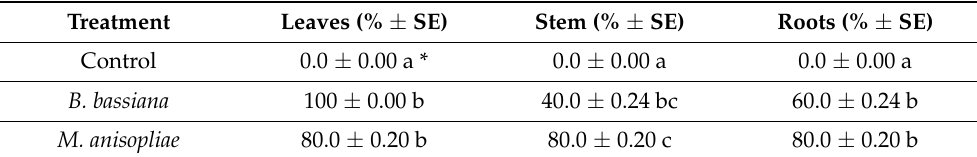
Table 1. Effect of conidial seed treatments on percentage recovery of B. bassiana and M. anisopliae from different parts of cucumber seedlings grown in autoclaved soil pots under controlled conditions in the greenhouse.